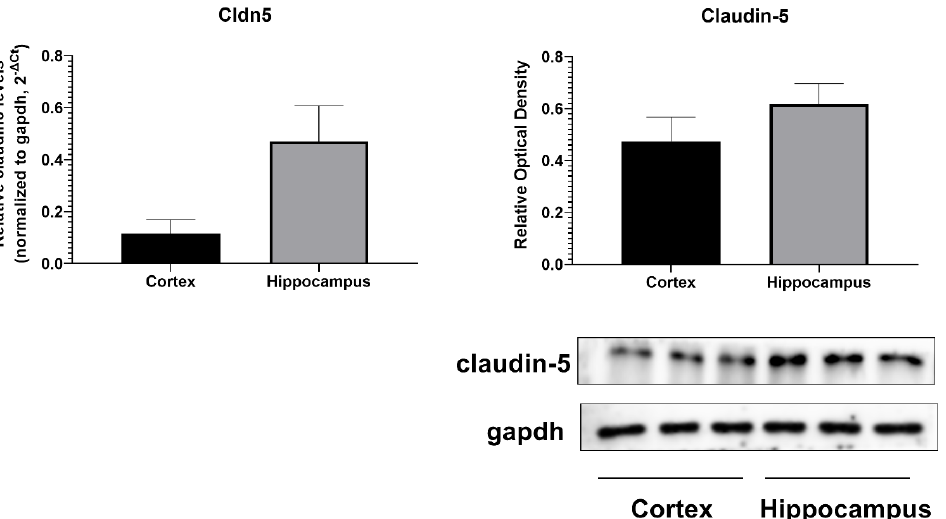
Figure 3. Levels of the inter-endothelial junctional protein (claudin-5) in mouse brain micro vessels isolated from the cortex and the hippocampus.